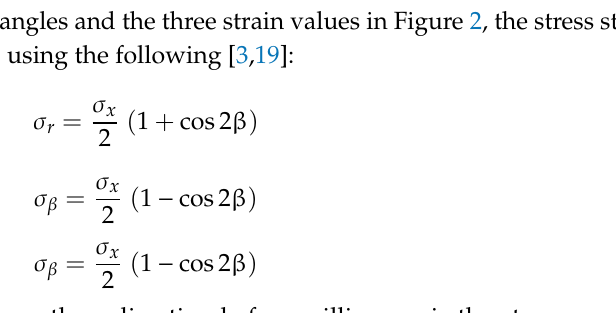
Figure 2. Infinite flat plate subjected to a biaxial tensile stress diagram ( a ) before drilling and ( b ) after drilling.